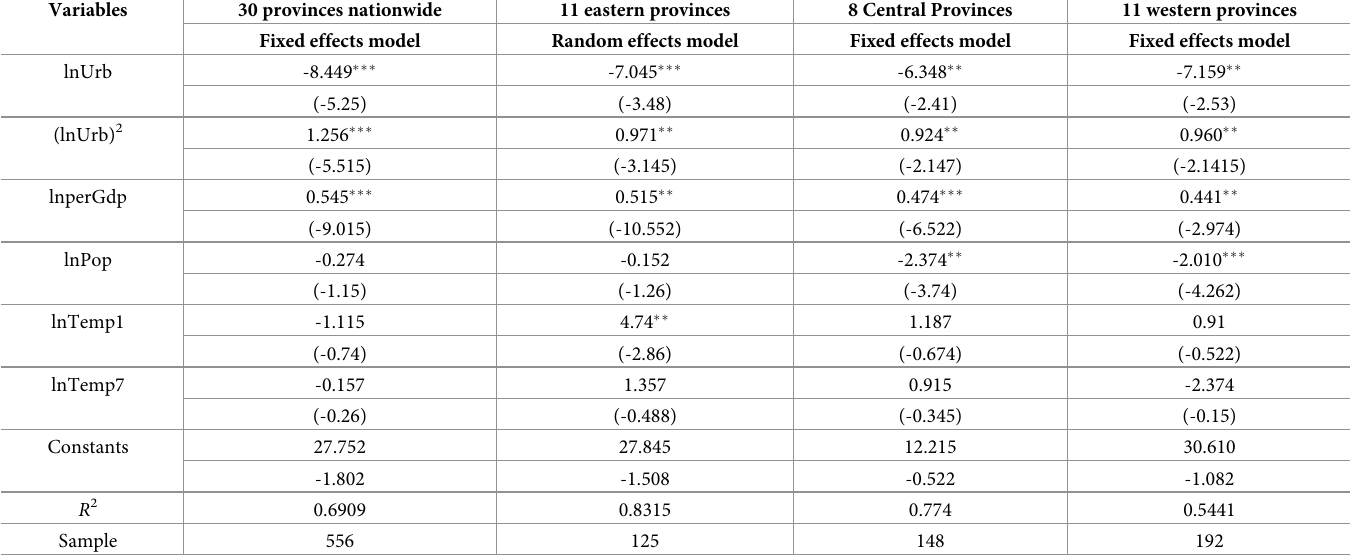
Table 4. Estimation results of the residential direct energy consumption